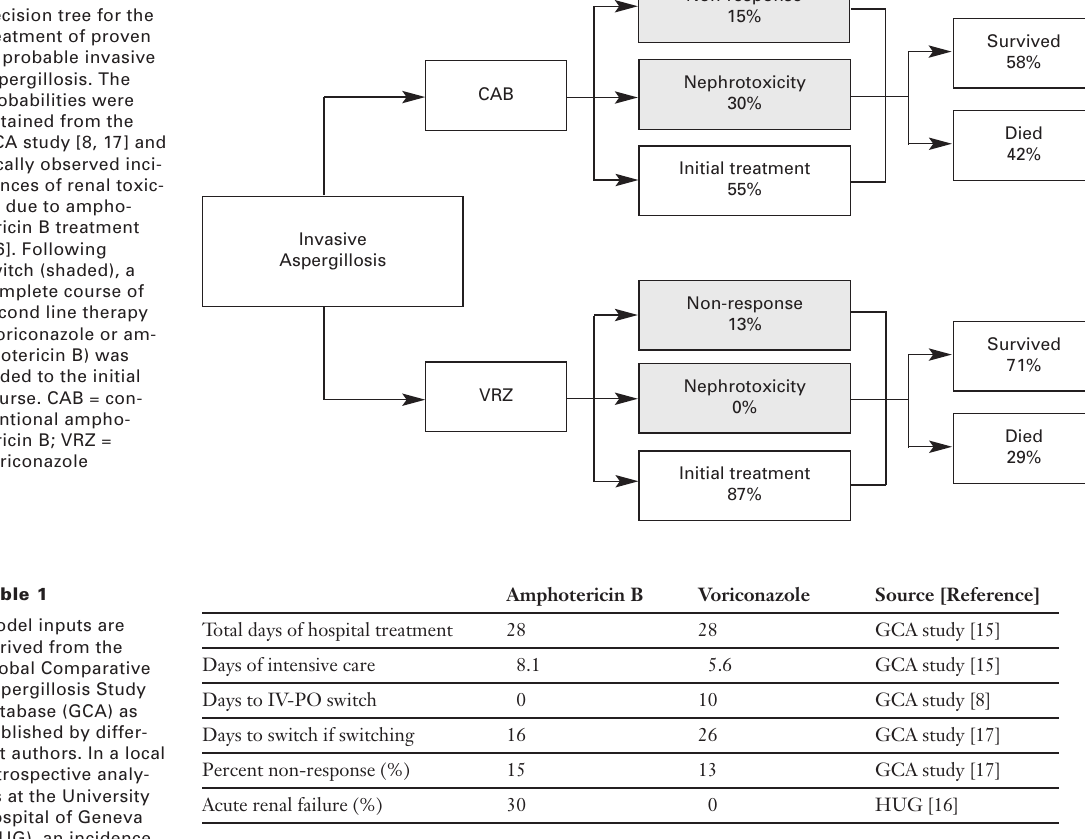
Figure 1 Decision tree for the treatment of proven or probable invasive aspergillosis. The probabilities were obtained from the GCA study [8, 17] and locally observed inci- dences of renal toxic- ity due to ampho- tericin B treatment [16]. Following switch (shaded), a complete course of second line therapy (voriconazole or am- photericin B) was added to the initial course. CAB = con- ventional ampho- tericin B; VRZ = voriconazole